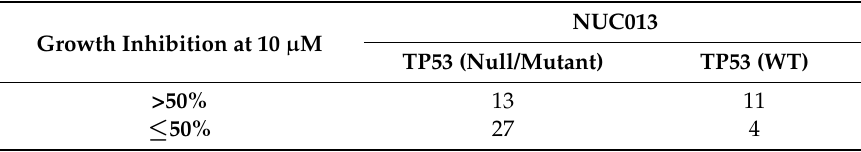
Table 4. Allocation of cell lines in NCI 60 cell line panel treated with NUC013 by growth inhibition at 10 µ M and TP53 status.